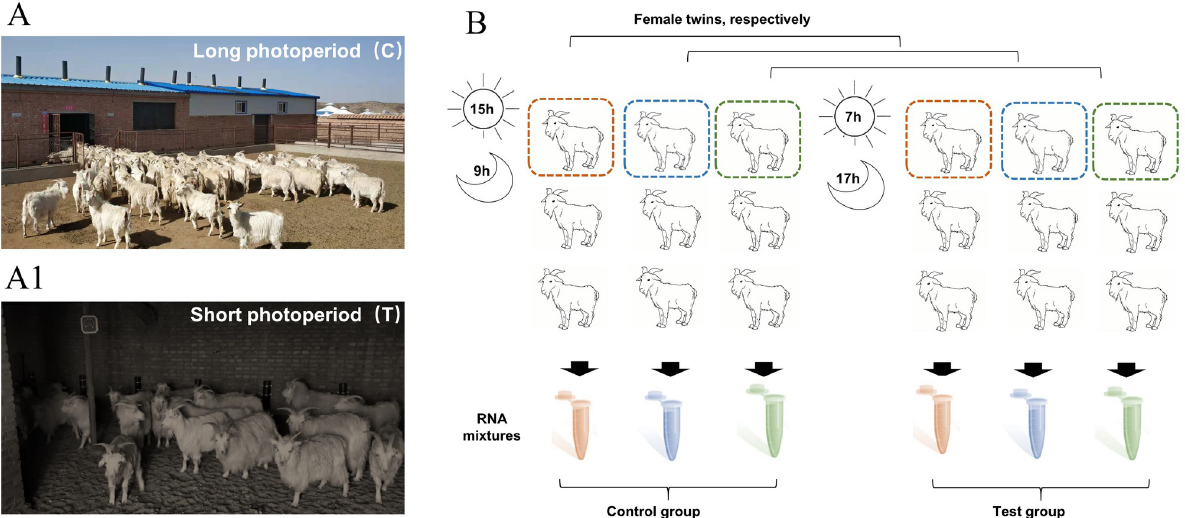
Fig 1. Light control technology and the experimental design. (A) Cashmere goats under natural light (control group), (A1) Cashmere goats under limited illumination using light control technology (experimental group), (B) Experimental design. A total of 18 cashmere goats were respectively divided into test (T) and control group (C). Six RNA mixtures from two groups were extracted for